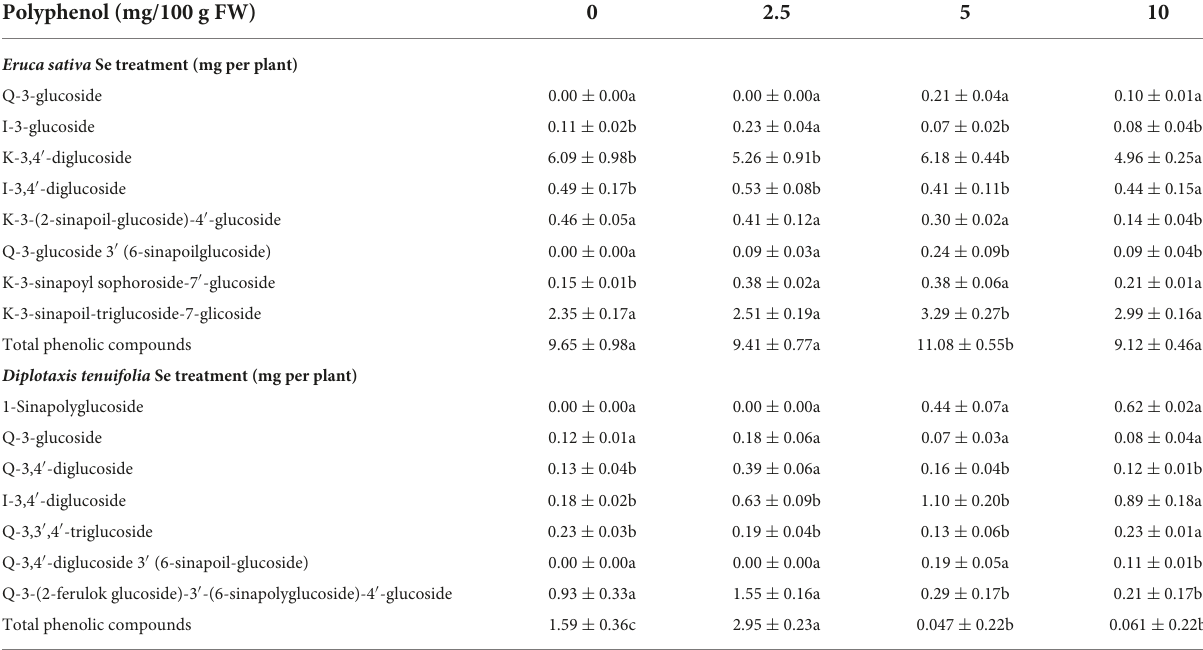
TABLE 2 Content of phenolic compounds identified in leaves in leaves of rocket species ( Eruca sativa and Diplotaxis tenuifolia ) grown in soil and foliarly fertilized with selenate dosages ranging from 0 to 10 mg per plant. Polyphenol (mg/100 g FW)